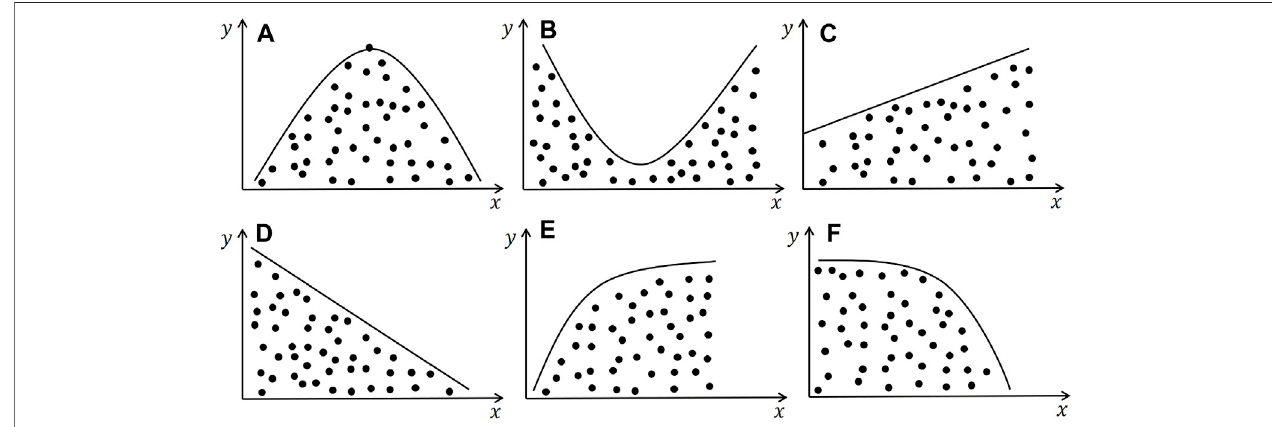
FIGURE3| TypesofconstraintlinesbetweenESs. (A) Hump-shapedcurve; (B) U-shapedcurve; (C) positivelinearline; (D) negativelinearline; (E) positiveconvex curve; (F) negative convex curve. (Modi fi ed from Lester et al., 2013; Hao et al., 2017).